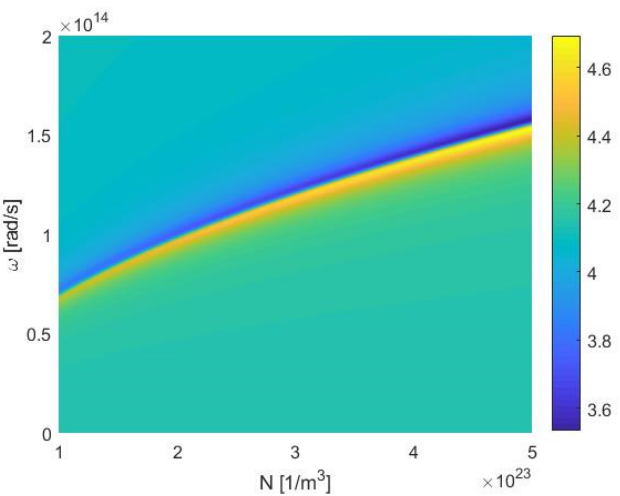
Figure 3. Dependence of the ε ┴ upon frequency and concentration of the free carriers.